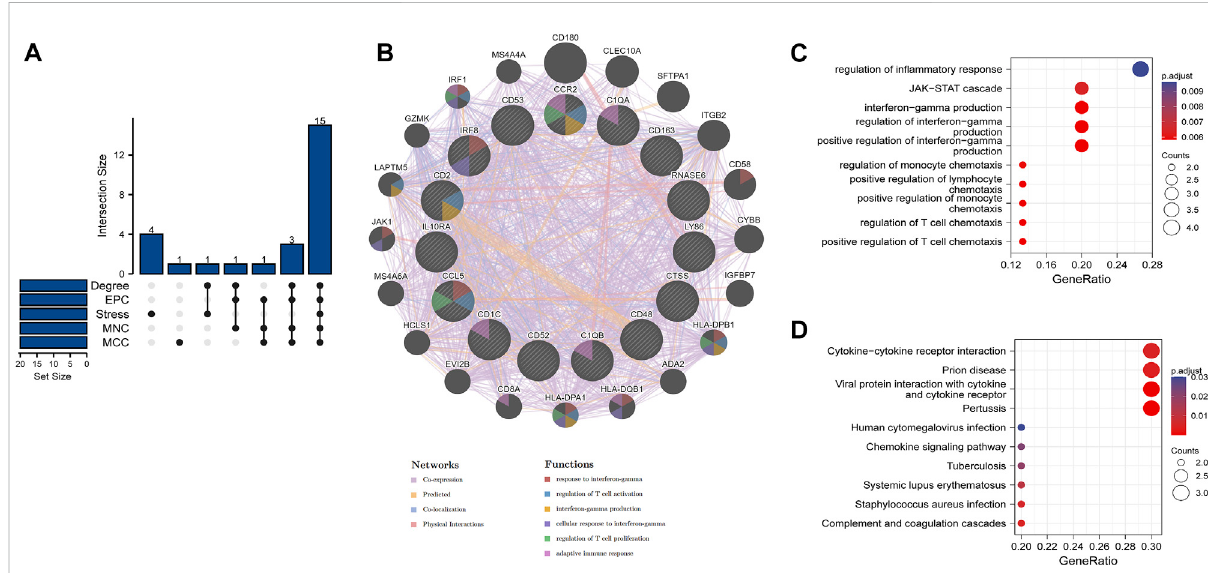
FIGURE 4 Venn diagram, coexpressed network of hub genes, and enrichment analyses of hub genes (A) 15 hub genes were identi fi ed by fi ve algorithms. (B) Coexpressed network of hub genes was shown with the GeneMANIA online tool. The hub genes were located in the inner circle, while the functionally similar genes were located in the outer circle. (C) GO enrichment analysis of hub genes was constructed using a bubble plot. (D) KEGG pathway of hub genes was constructed using a bubble plot. Adjusted p -value < 0.05 was considered as signi fi cant.